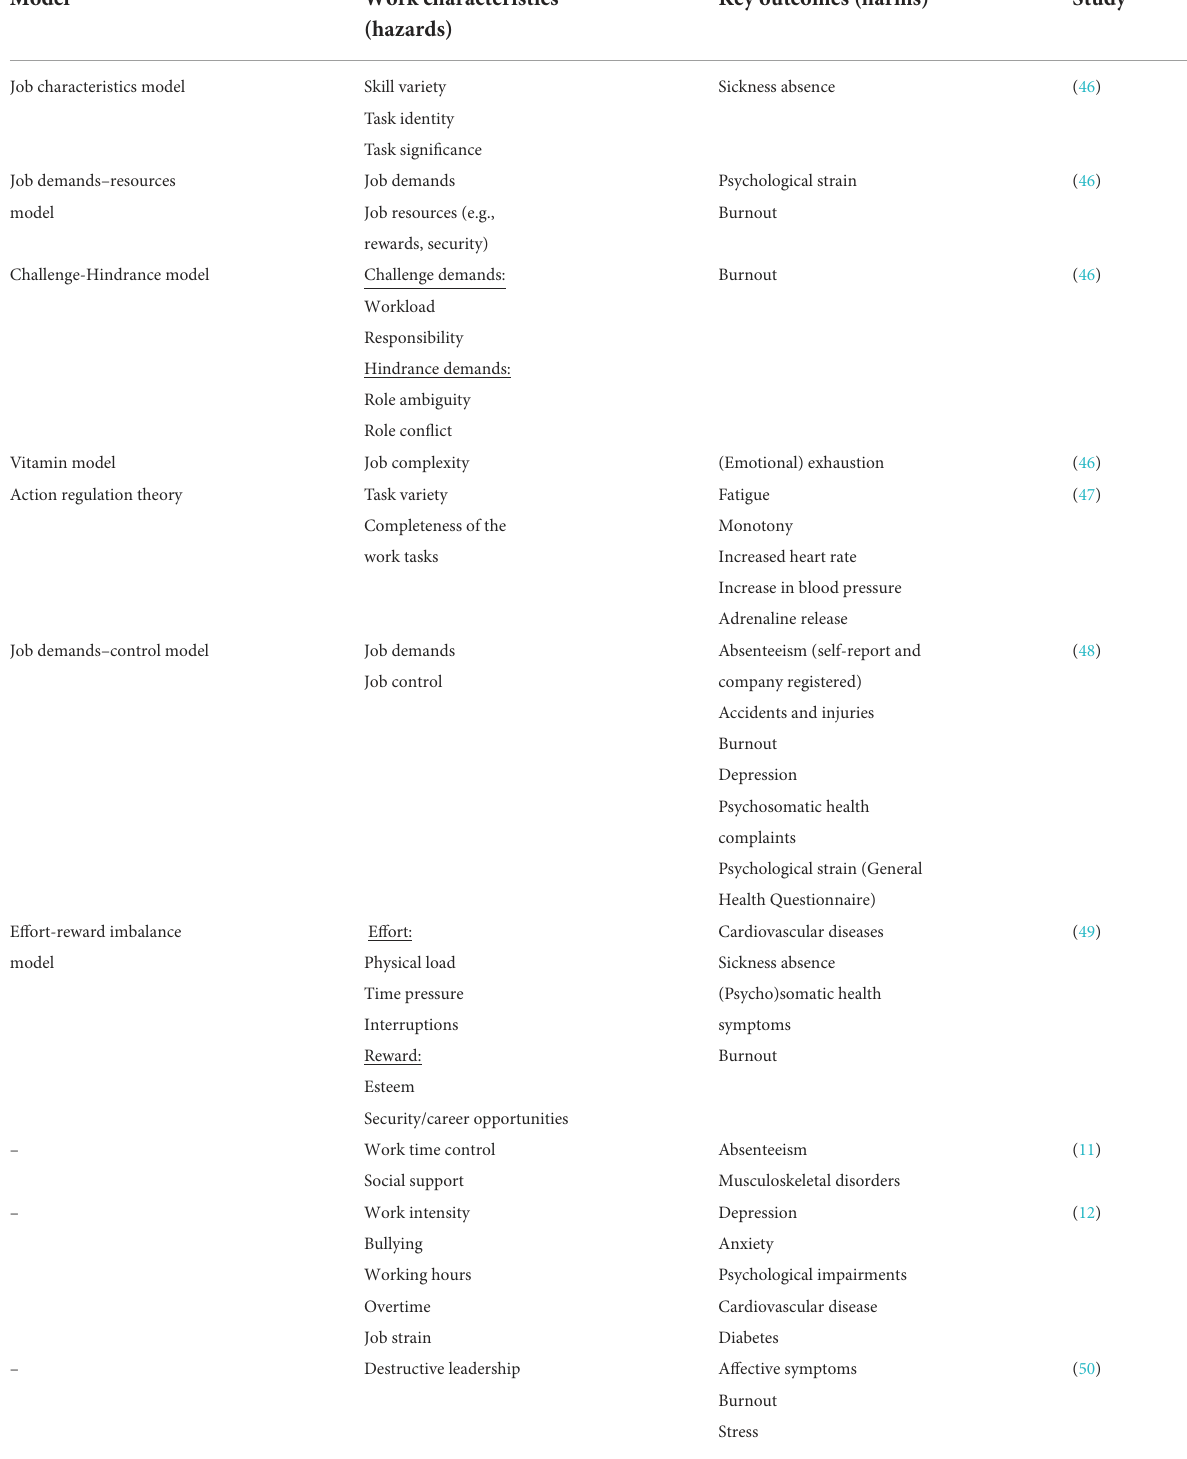
TABLE 2 Relevant work characteristics and key outcomes across different work-related health